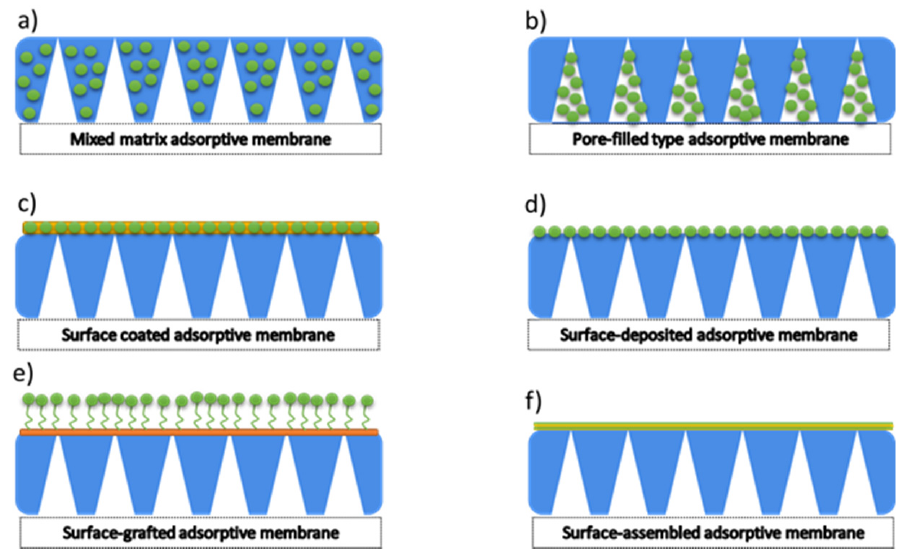
Figure 6. Types of adsorptive membranes. Reproduction from [75].